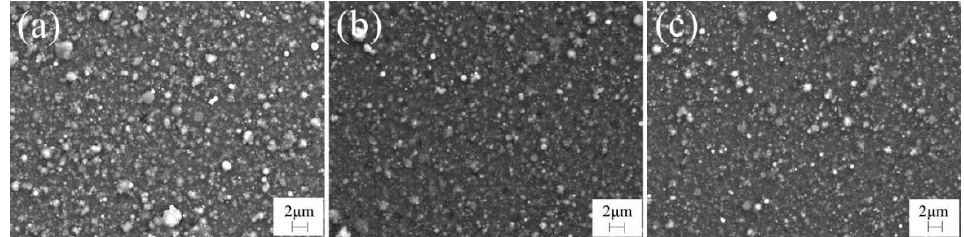
Figure 3. Surface morphologies of the three coatings: ( a ) AlCrSiN coating, ( b ) AlCrSiON coating, ( c ) AlCrSiN/AlCrSiON duplex coating.